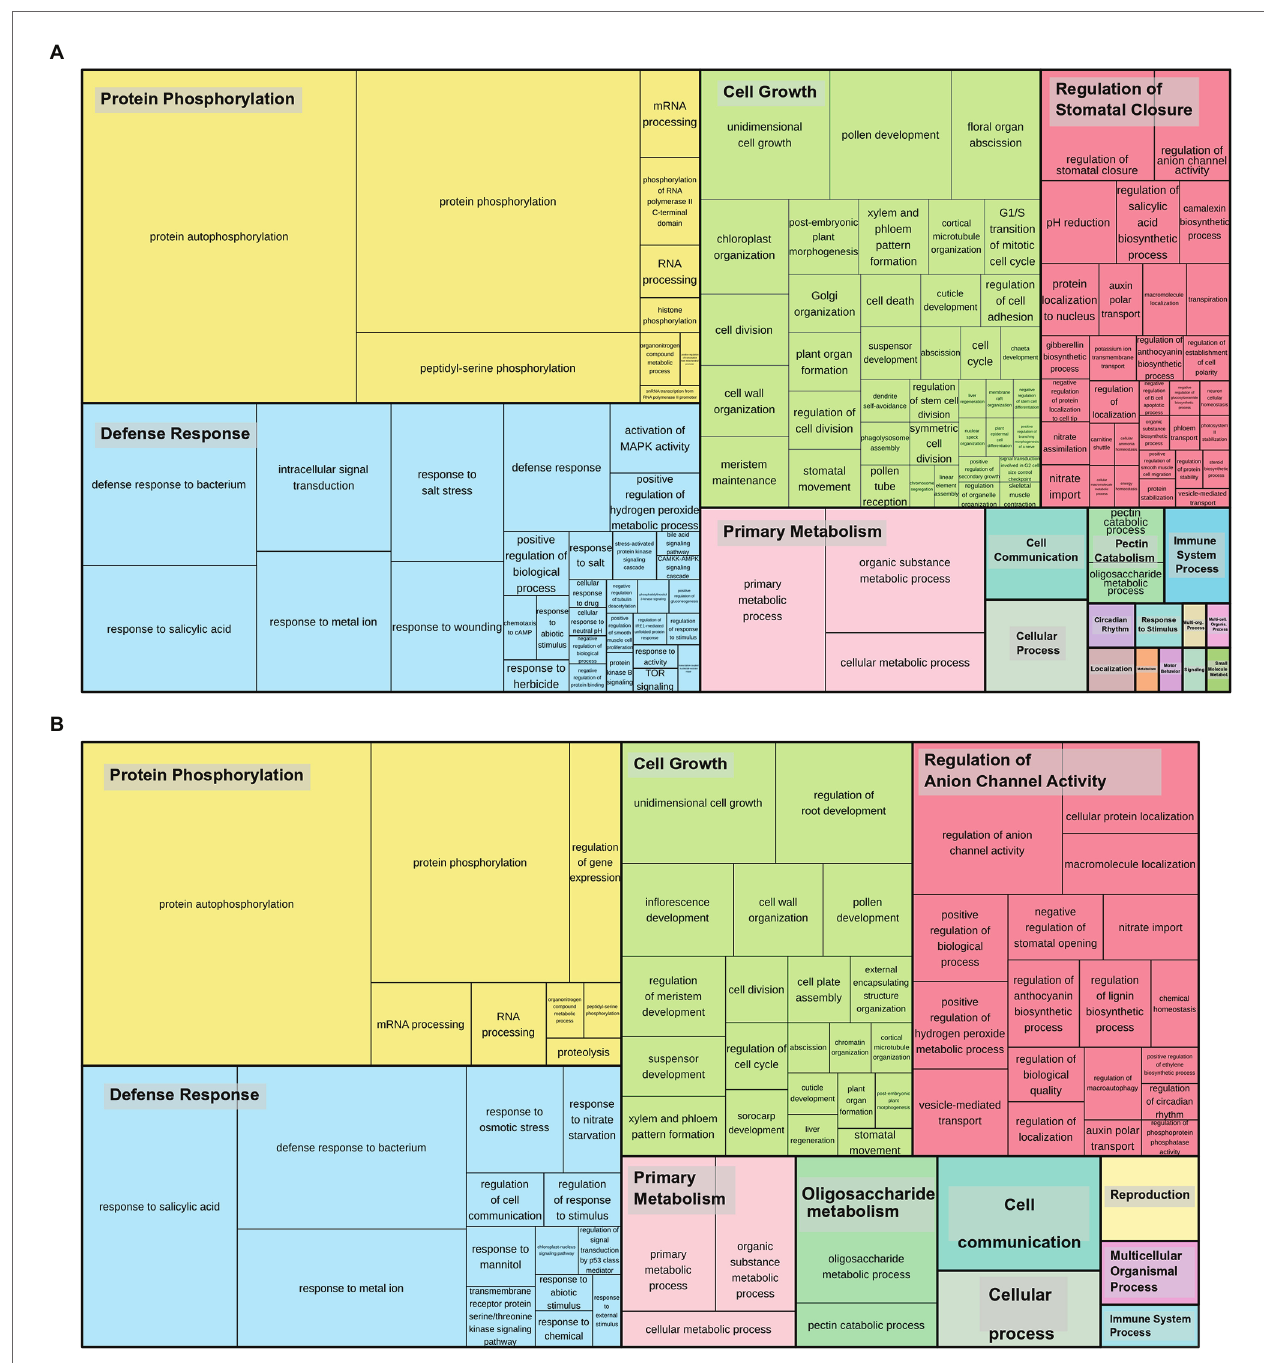
FIGURE 4 | Gene Ontology (GO) categories (biological processes) related to tandemly duplicated kinases in (A) S. spontaneum and (B) Sbi. The size of the subdivisions within the blocks represents the abundance of that category in this set of kinases. The colors are related to the similarity to a representative GO annotation for the